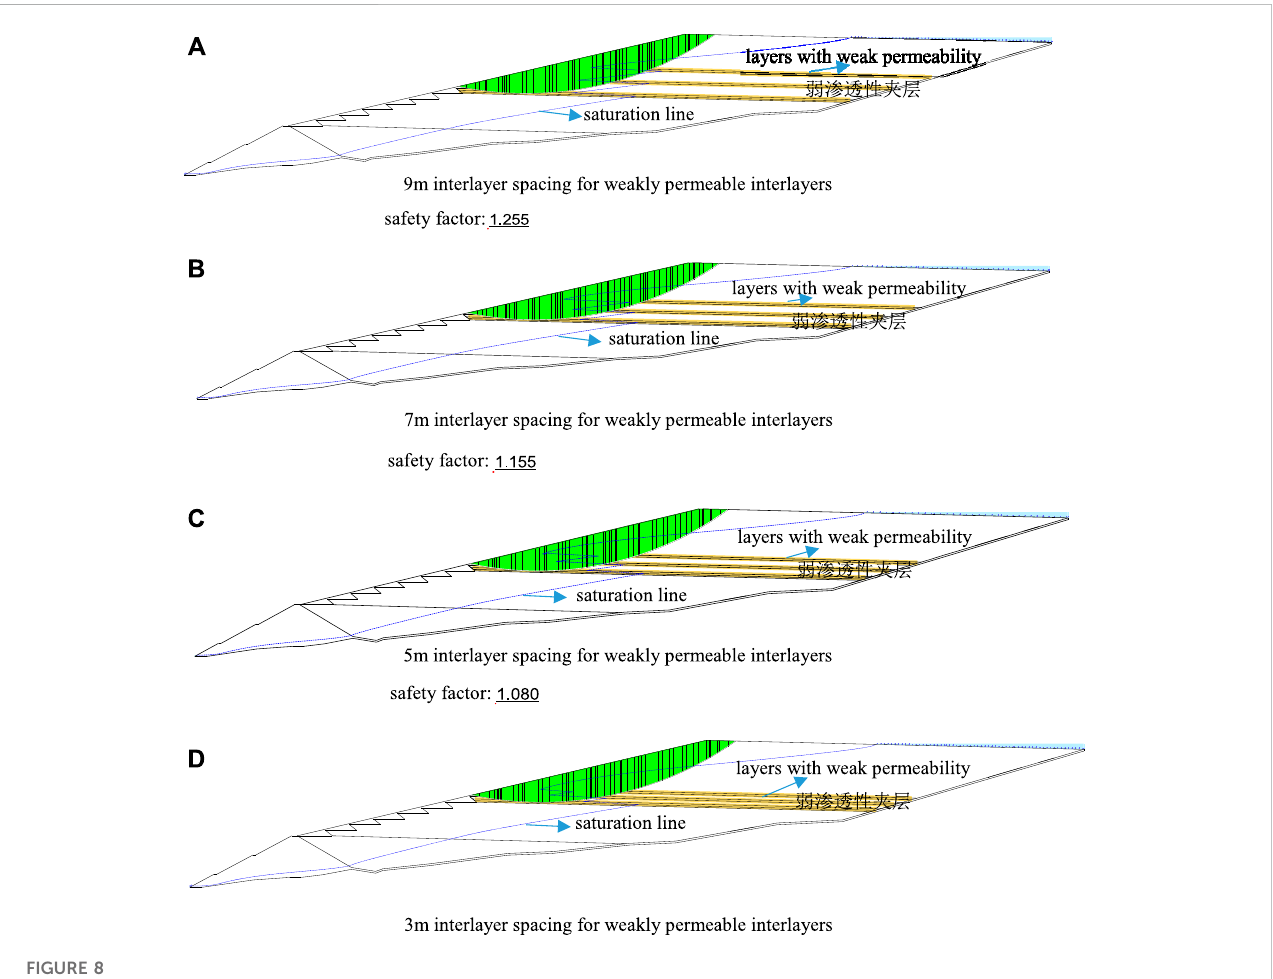
FIGURE 8 The curve of the interlayer spacing of low-permeability layer and safety factor. (A) 9 m interlayer spacing for weakly permeable interlayers. (B) 7 m interlayer spacing for weakly permeable interlayers. (C) 5 m interlayer spacing for weakly permeable interlayers. (D) 3 m interlayer spacing for weakly permeable